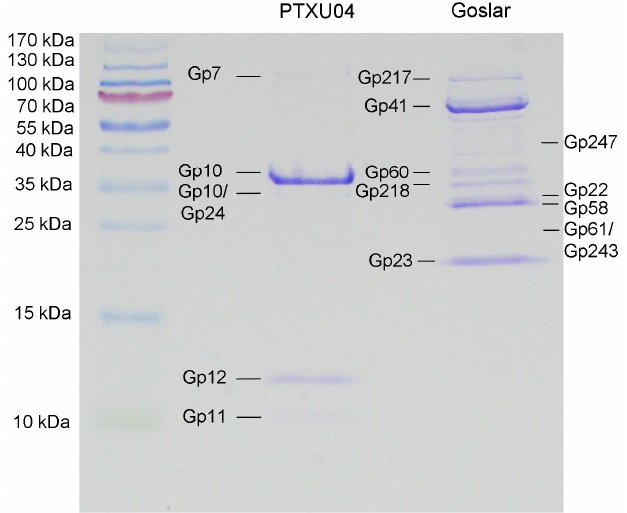
Figure 8. Genomic organization of PTXU04. Genes for identified structural proteins using peptide mass fingerprinting are marked in red, putative genes for DNA packaging in orange, putative genes for lysis in yellow, and genes involved in replication in blue (put. = putative).